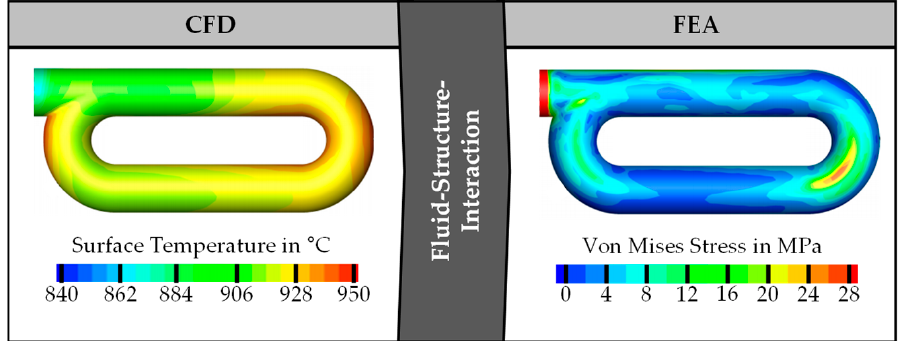
Figure 2. FSI workflow to calculate P-type radiant tube deformation [2].